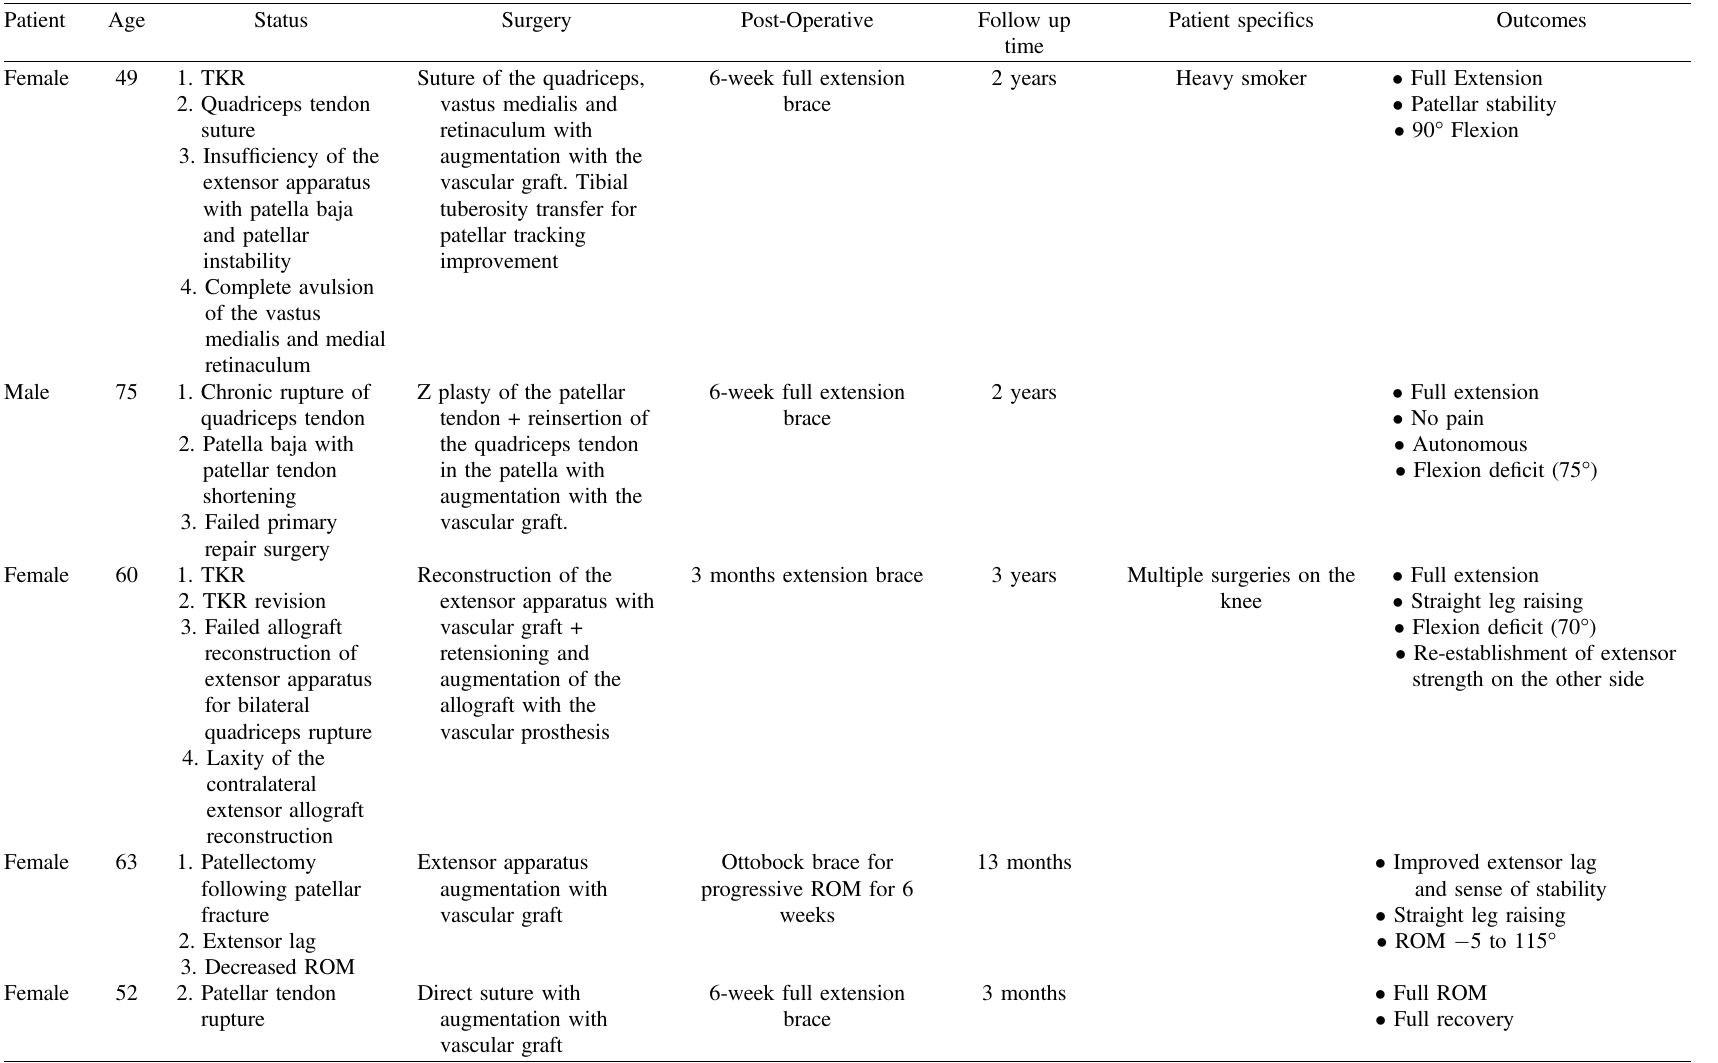
Table 1. Some of the complicated cases this technique was developed to solve.